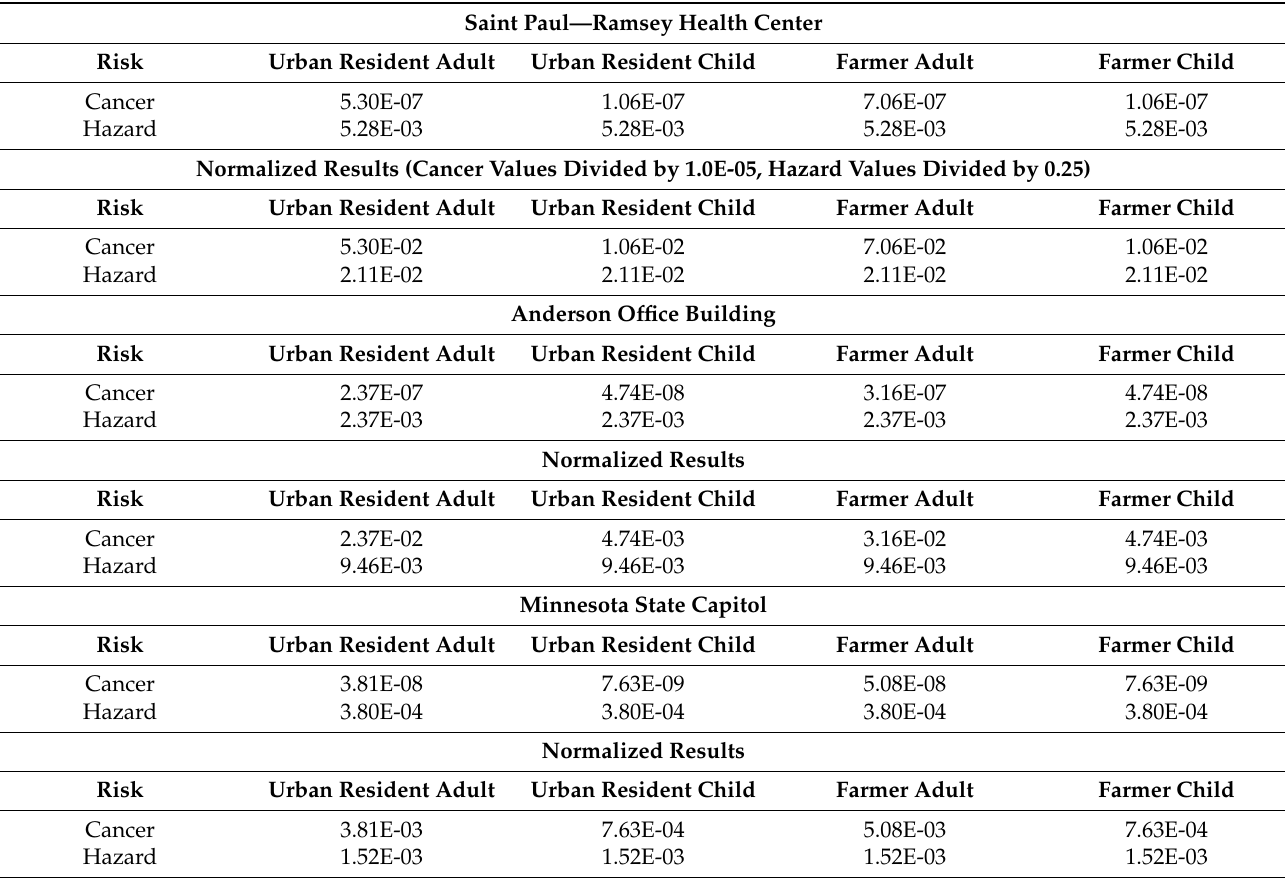
Table 10. Total Individual Benzene Cancer Risks and Noncancer Hazards. Saint Paul—Ramsey Health Center